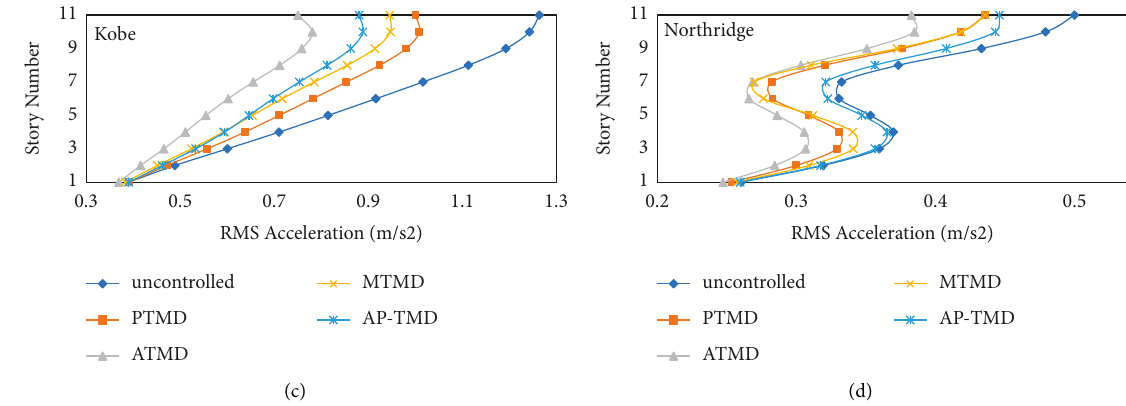
Figure 13: RMS acceleration of structures with different controllers under 4 earthquakes. (a) RMS acceleration of structure under El Centro earthquake. (b) RMS acceleration of structure under Hachinohe earthquake. (c) RMS acceleration of structure under Kobe earthquake. (d) RMS acceleration of structure under Northridge earthquake.